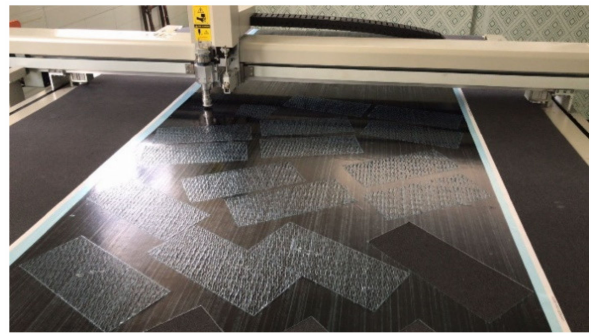
Figure 2. A commercial numerical control cutter.